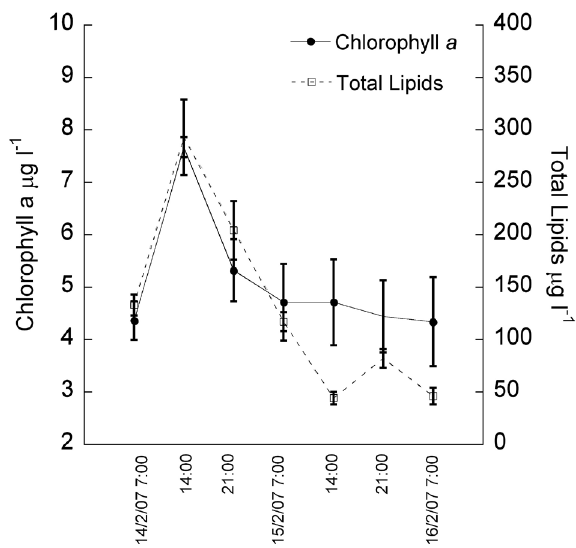
Fig . 1. – Chlorophyll a and total lipids (µg L -1 ) during the 48-hour cycle at Chipana Bay.